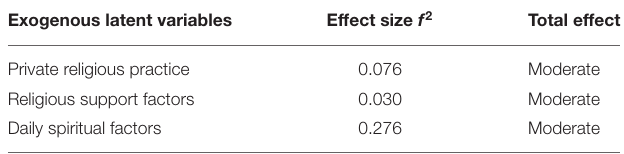
TABLE 9 | Fornell–Larcker criterion.